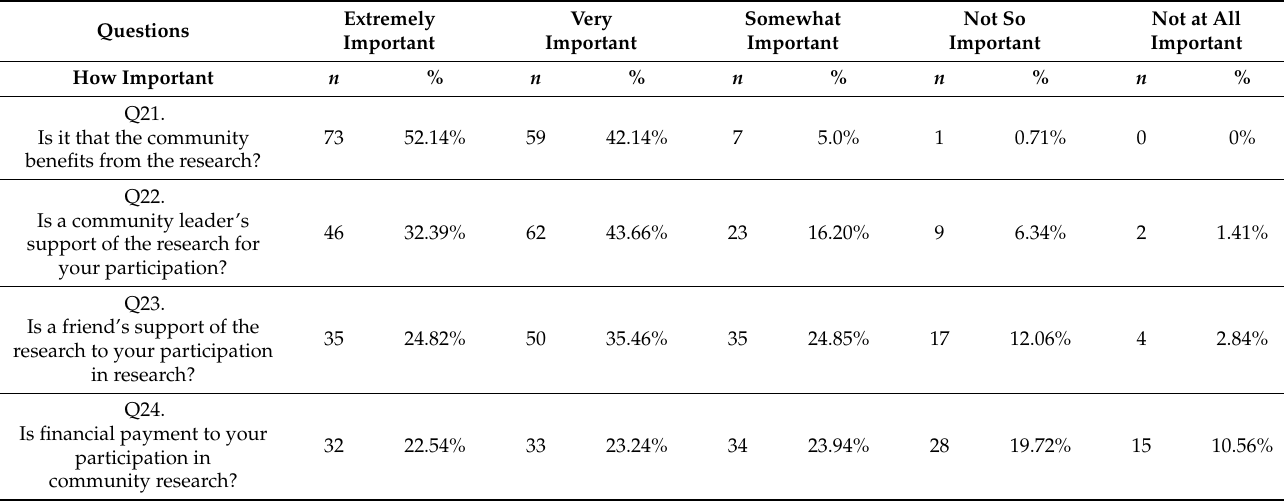
Table 4. Benefits of community